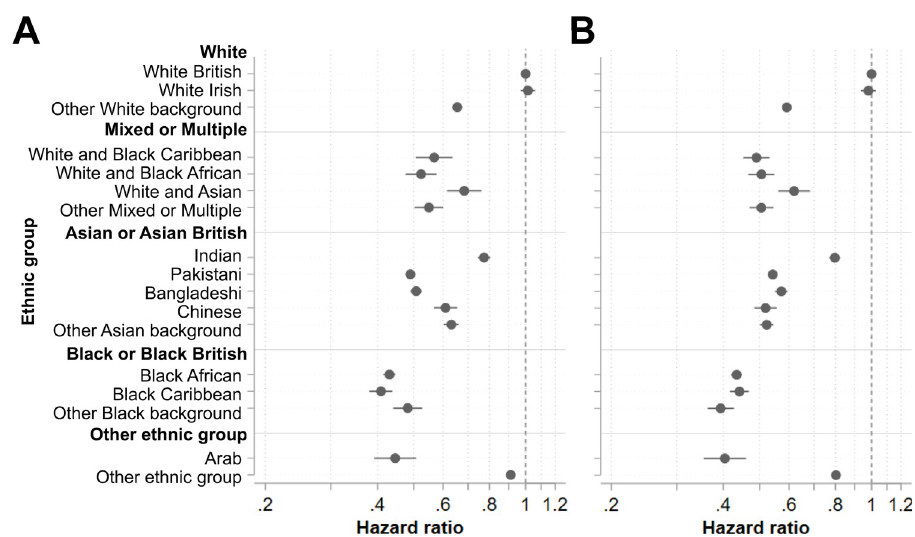
Fig 3. Associations between ethnic group and vaccine uptake by prior influenza vaccine uptake. Hazard ratios with 95% confidence intervals from Cox proportional hazards models estimating time to COVID-19 vaccination across ethnic groups adjusted by vaccine eligibility group amongst individuals eligible for both the COVID-19 and 2019/2020 seasonal influenza vaccines who (A) did take up 2019/2020 seasonal influenza vaccination and (B) did not take